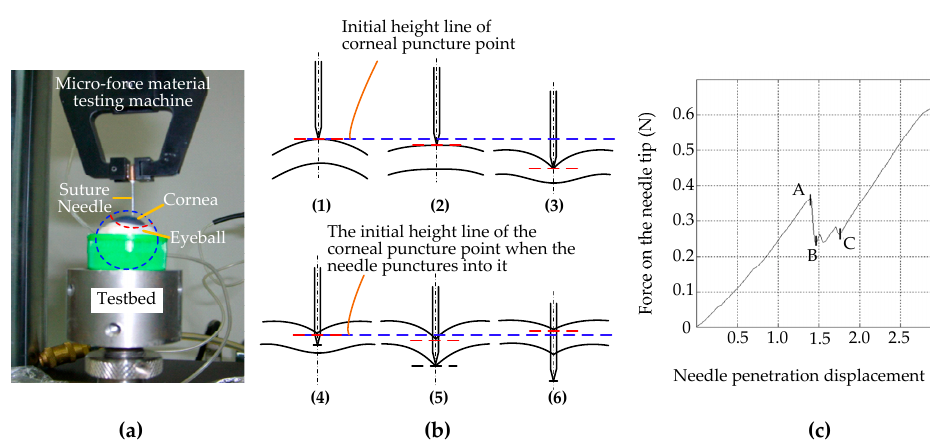
Figure 3. Cornea puncture experiment with suture needles. ( a ) Test system. ( b ) The corneal deformation during the whole piercing process: (1) The suture needle only just made contact with the upper surface of the cornea, and the force was 0. The corneal tissue was not deformed. (2) The needle began to exert force on the cornea, and the upper surface of the cornea was deformed but not punctured. (3) The needle continues to exert force on the cornea, close to puncturing the upper surface of the cornea. The degree of corneal tissue deformation increases gradually. (4) The suture needle punctured the upper surface of the cornea and began to penetrate the corneal stroma. (5) The suture needle continues to move down and is about to puncture the lower surface of the cornea. (6) The suture needle punctured the lower surface of the cornea and continued to puncture the inside of the eyeball, while the deformation of the corneal tissue showed a little recovery. ( c ) The relationship curve between the stress of the suture needles and the penetration displacement.